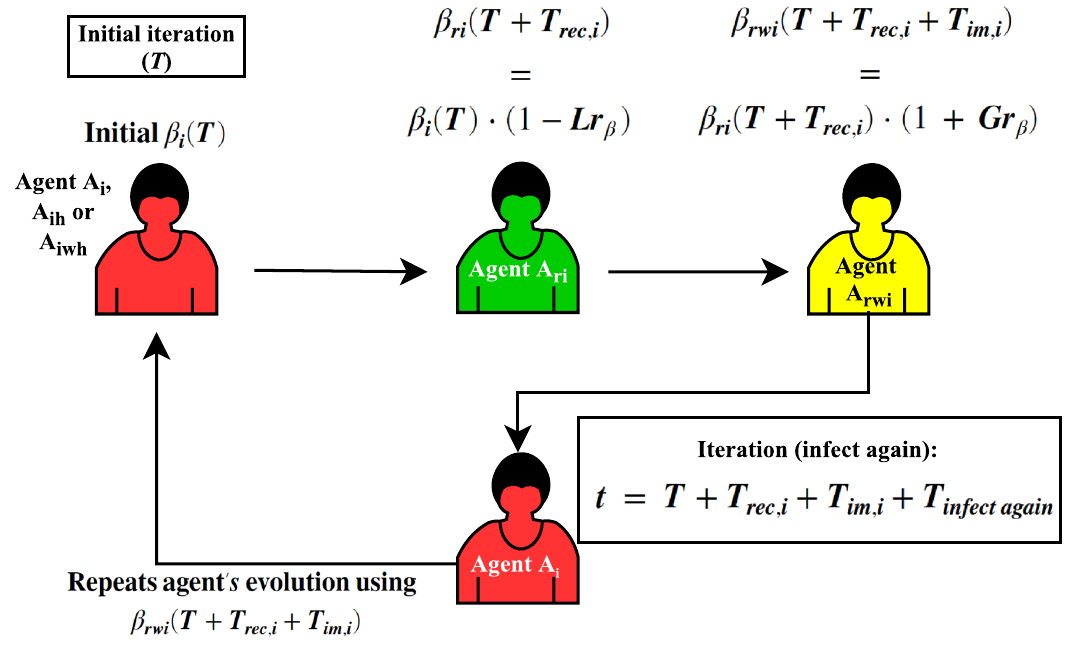
Figure 4. Roadmap of evolutions of the contagious’ probability ( β ) over time model interactions.